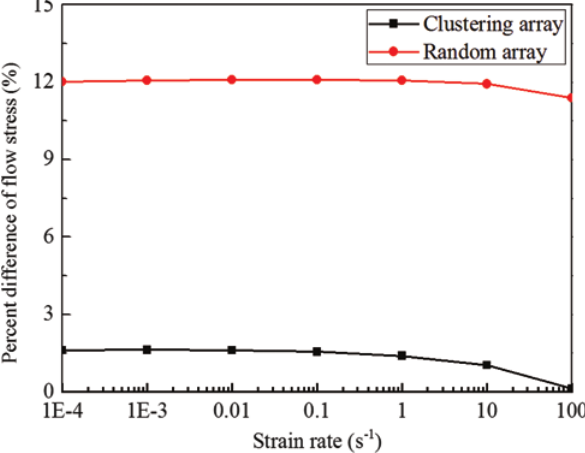
Figure 11: Percent difference changing with the strain rates for clustering and random fiber arrays.